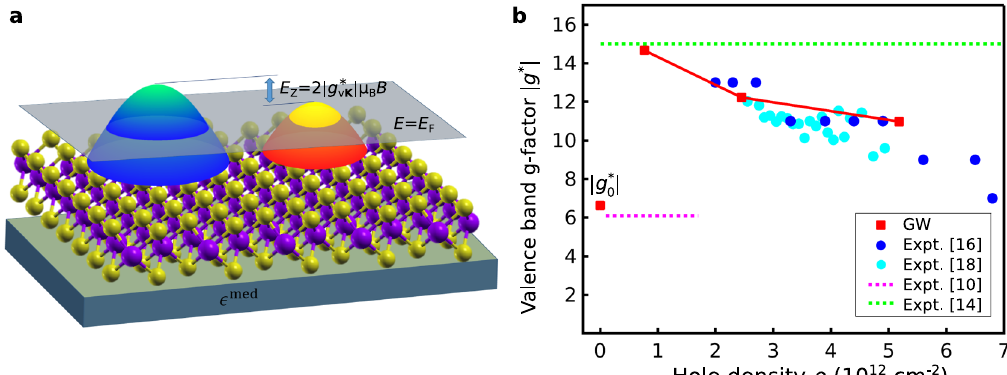
Fig. 1 Valence band g-factor in hole-doped ML WSe 2 . a Schematic fi gure of the energy dispersion of hole-doped WSe 2 ML in the presence of an out-of-plane magnetic fi eld, in the mixed-polarized regime where the g-factor is enhanced. b Valence band g-factor ∣ g * ∣ in hole-doped ML WSe 2 as a function of hole density. Red squares: Calculated results; Dark blue and light blue circles: Experimental data from refs. 16,18 , respectively; Purple and green dotted lines: Experimental data from refs. 10,14 , respectively (hole densities are given in a range